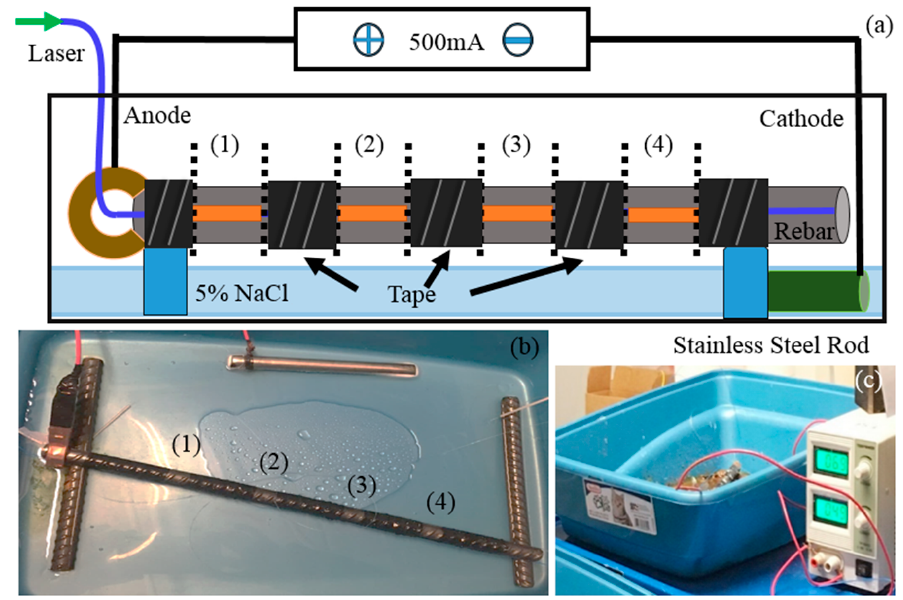
Figure 6. The experimental setup of corrosion monitoring on steel rebar specimen. ( a ) Schematic of accelerated corrosion test (ACT) setup. ( b ) Four spraying sections of steel rebar specimen. ( c ) Keeping a constant current of 500 mA.